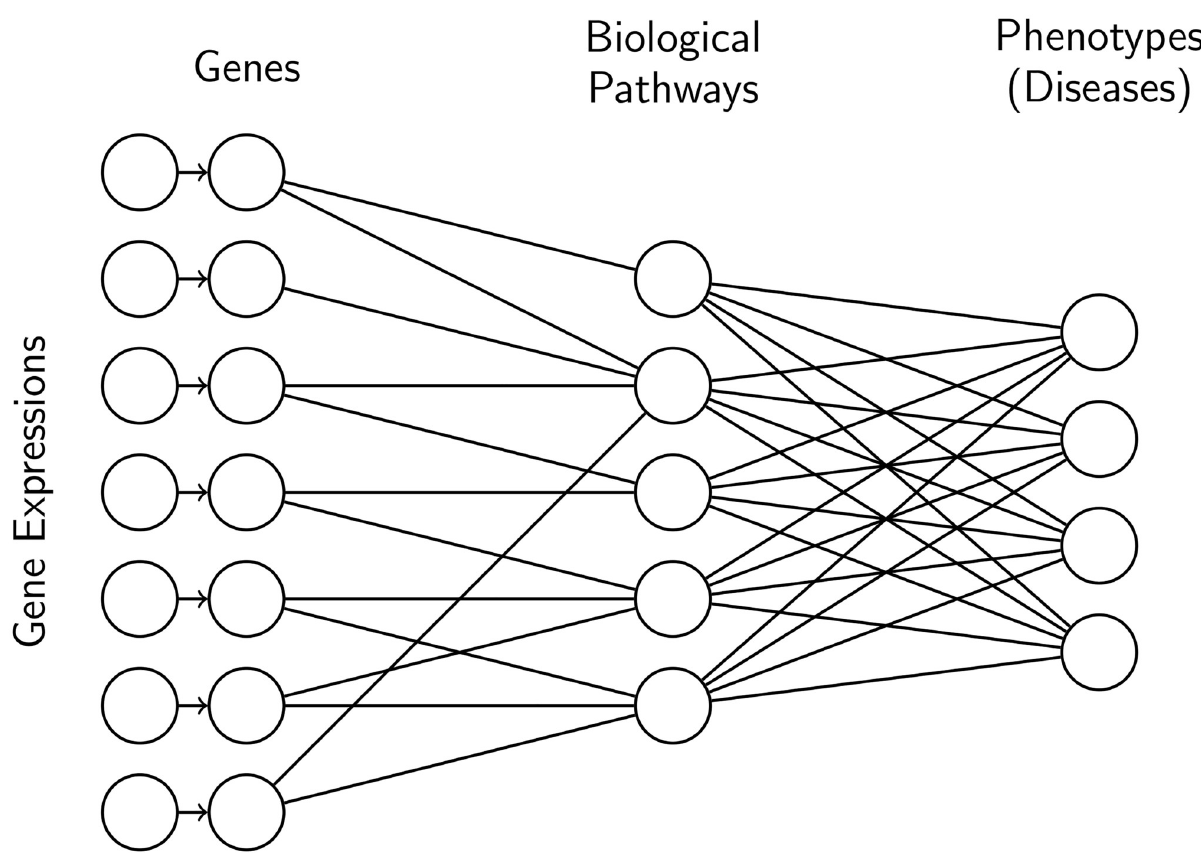
Fig 1. Example of neural network architecture. For the first layer, the connections are defined by biological information, i.e. a unit representing a gene is connected to all the biological pathways that the gene is involved in. We do not add any prior knowledge on the last layer, thus it is fully connected.